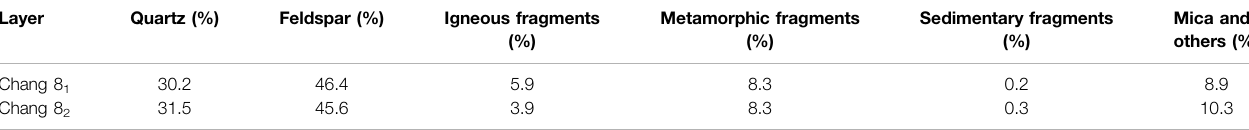
TABLE 1 | Detrital composition content of Chang 8 reservoir in Wuqi – Zhijing – Ansai area. Layer Quartz (%) Feldspar (%) Igneous fragments